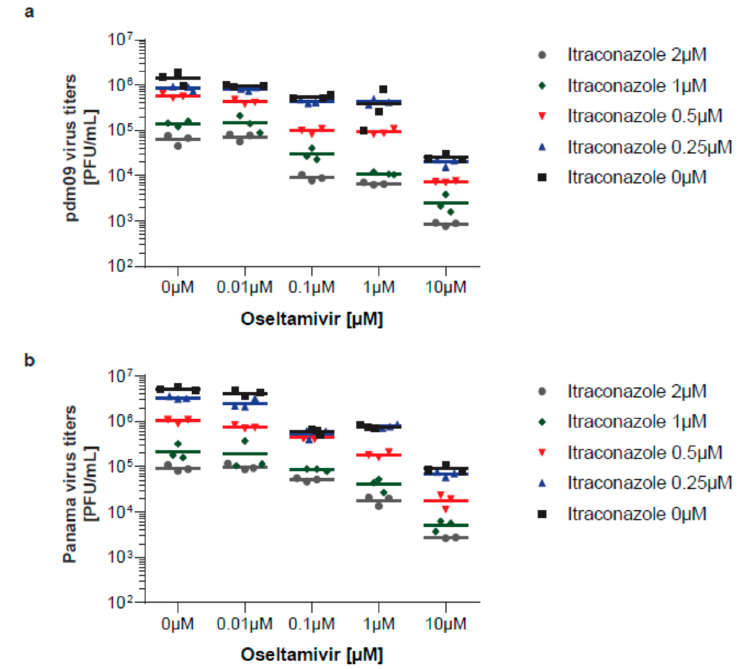
Figure 4. Individual virus titers obtained in all experimental samples. Viral titers obtained in cells infected with ( a ) pdm09 and ( b ) Panama are expressed as plaque-forming units (PFU) per mL with means and are presented on a logarithmic scale.